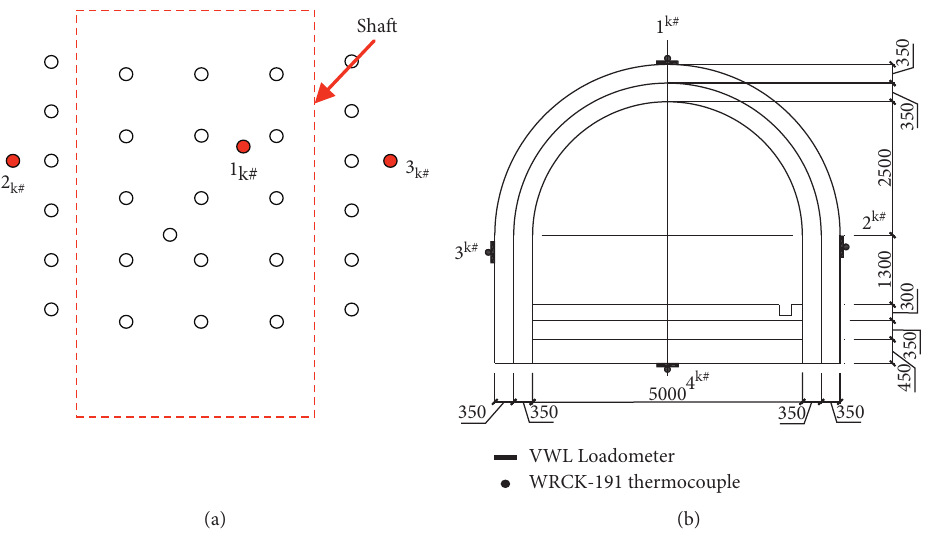
Figure 12: On-site monitoring points. (a) Temperature monitoring points. (b) Freezing pressure monitoring